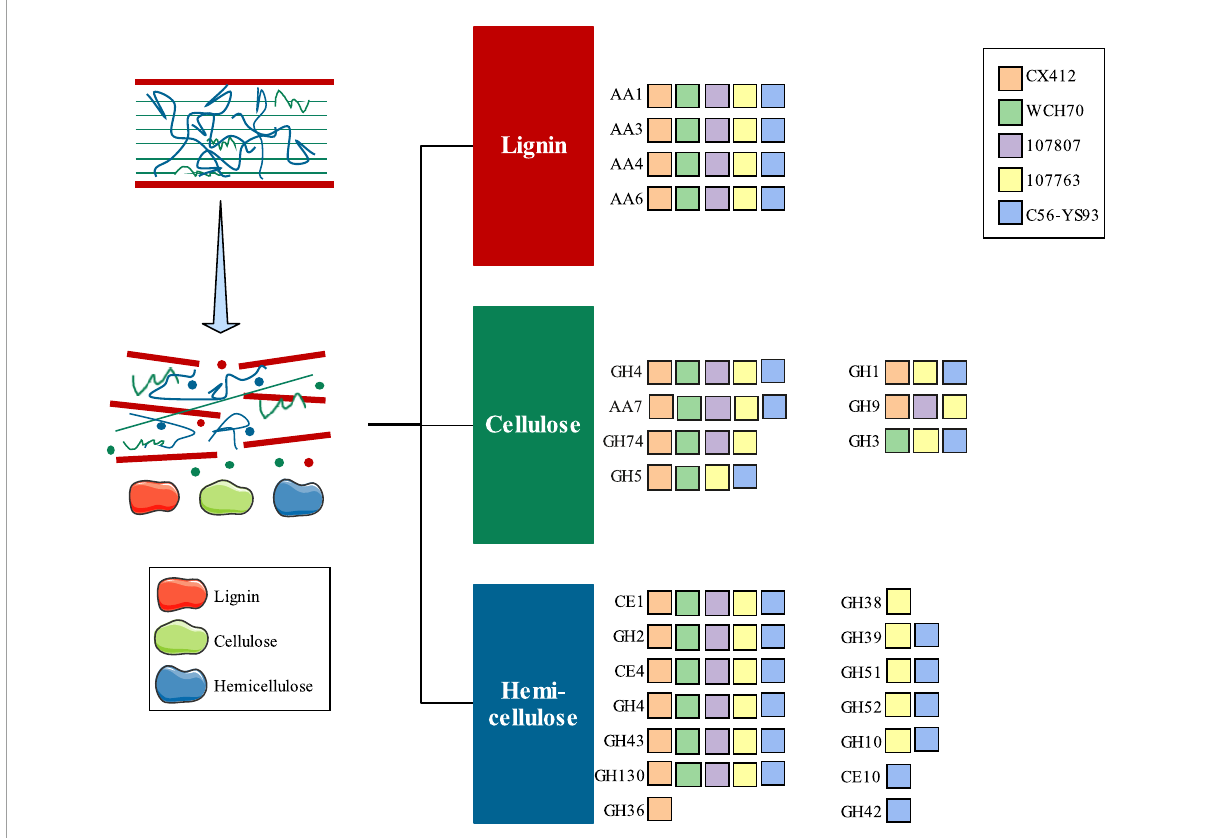
FIGURE6 An overview of lignocellulose degradation. AA, Auxiliary Activities; CE, Carbohydrate Esterases; GH, Glycoside Hydrolases. CX412, Geobacillus sp. CX412; WCH70, Geobacillus sp. WCH70; 107807, Parageobacillus toebii NBRC 107807; 107763, Parageobacillus thermoglucosidasius NBRC 107763; C56-YS93, Parageobacillus thermoglucosidasius